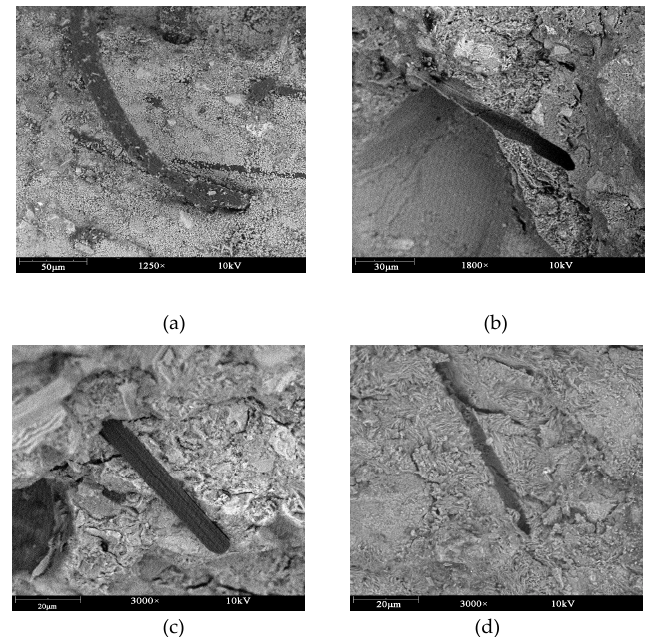
Figure 18. The final state of the PVA fiber specimens with different heat rates: ( a ) PVA at 25 °C; ( b )